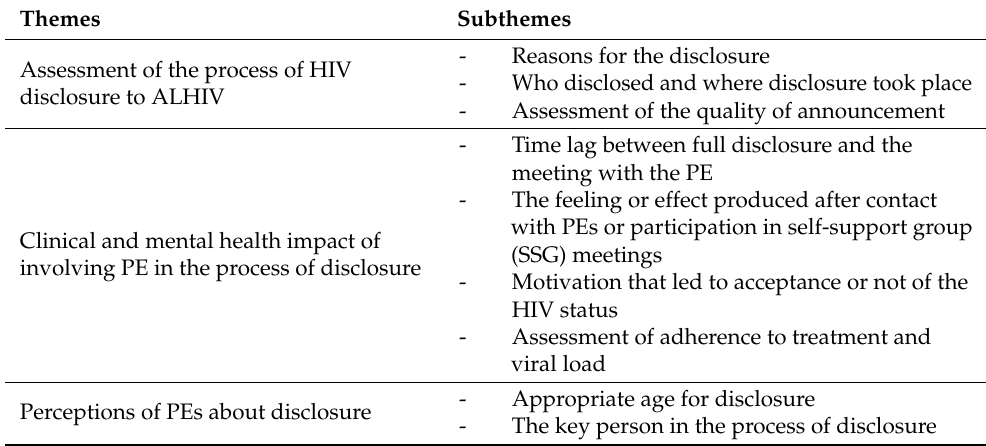
Table 1. Themes and subthemes that